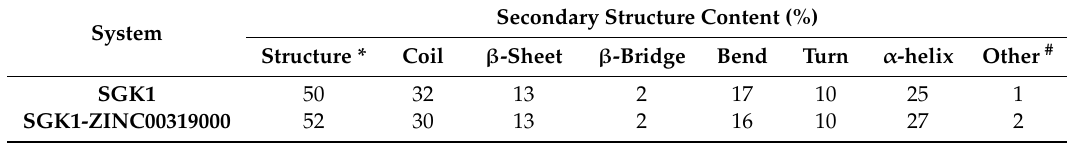
Table 8. The percentage of residues participated in the average structure formation of SGK1.